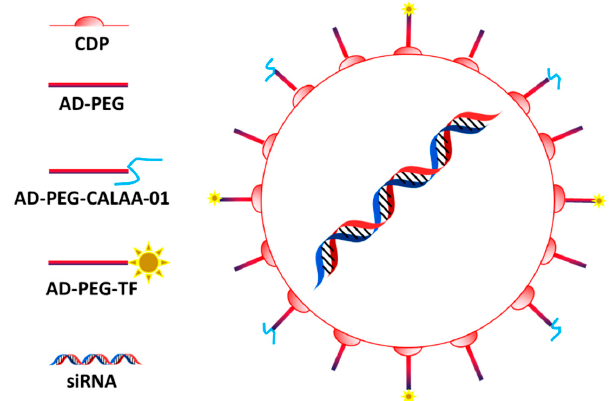
Figure 2. CALAA-01 structure: The system is composed by a core of cyclodestrin encapsulating the siRNA and functionalized with PEG bearing adamantine (AD-PEG) and transferrin (AD-PEG-TF). Figure from Kurreck et al. [72] .